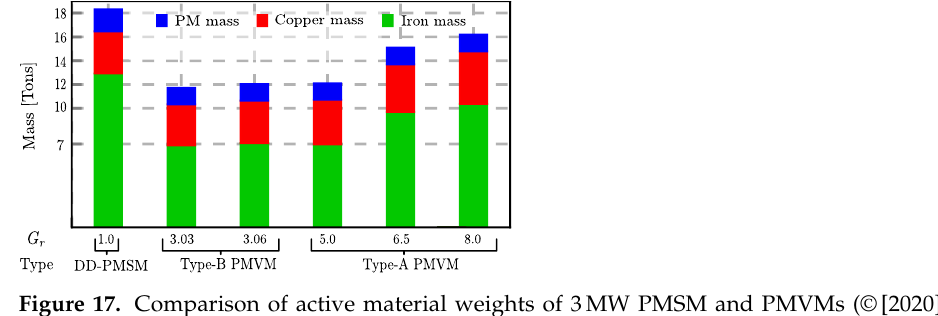
Figure 17. Comparison of active material weights of 3MW PMSM and PMVMs (©[2020] IEEE. Reprinted, with permission from [20]).